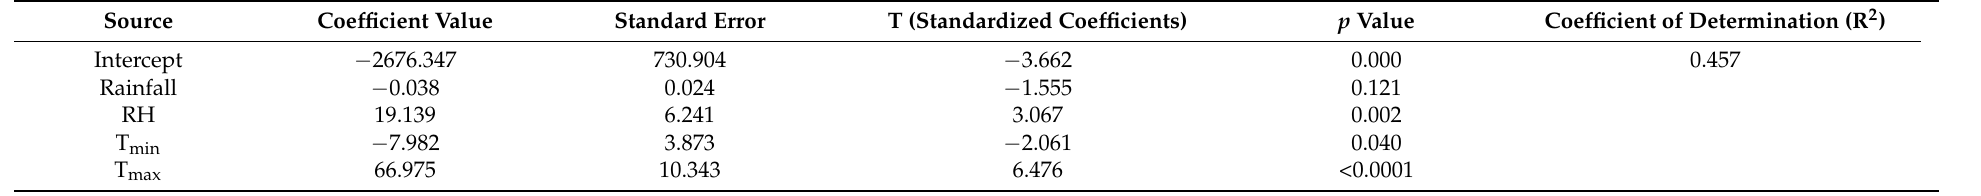
Table 7. Regression analysis of weather variables influencing black Sigatoka severity (AUDPC) at four test sites in Uganda and